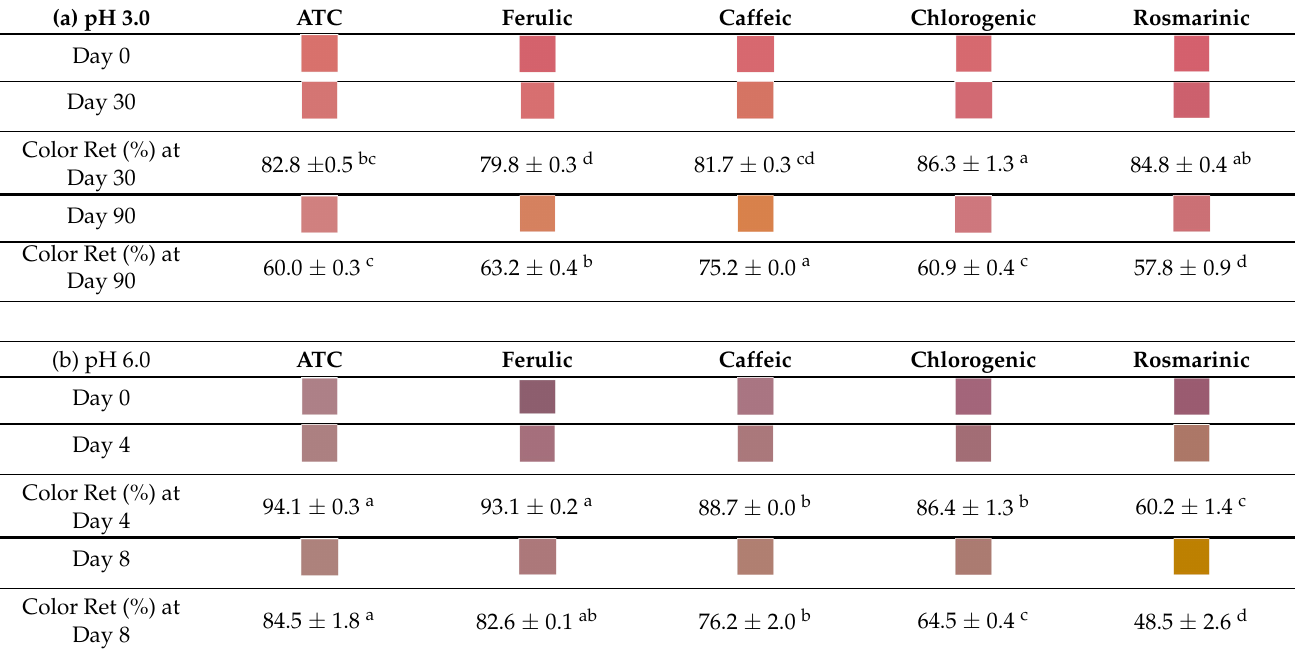
Table 3. Effect of intermolecular copigmentation on color range retention during storage at 20 ◦ C, at pH